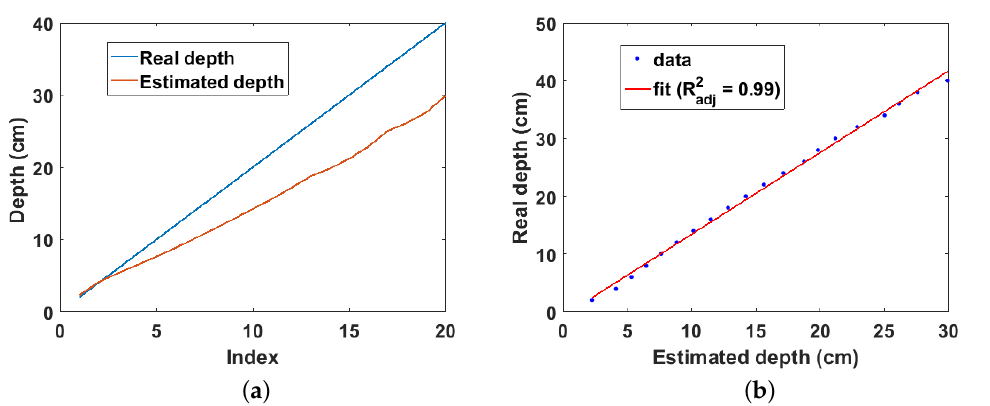
Figure 6. ( a ) Real and estimated depths for Cs-137 buried in sand. Index is the position of each depth value in the depth array; ( b ) linear fit of real and estimated depth for Cs-137 buried in